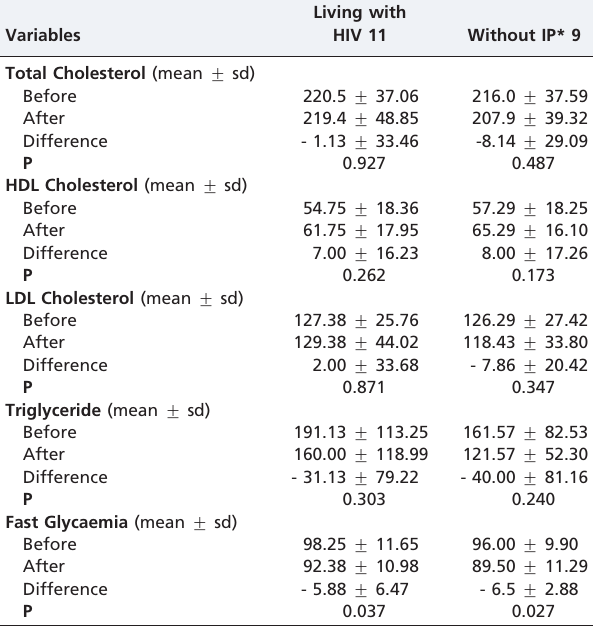
Table 2 - Lipid and blood sugar profile of elderly people living with HIV, before and after the training program.